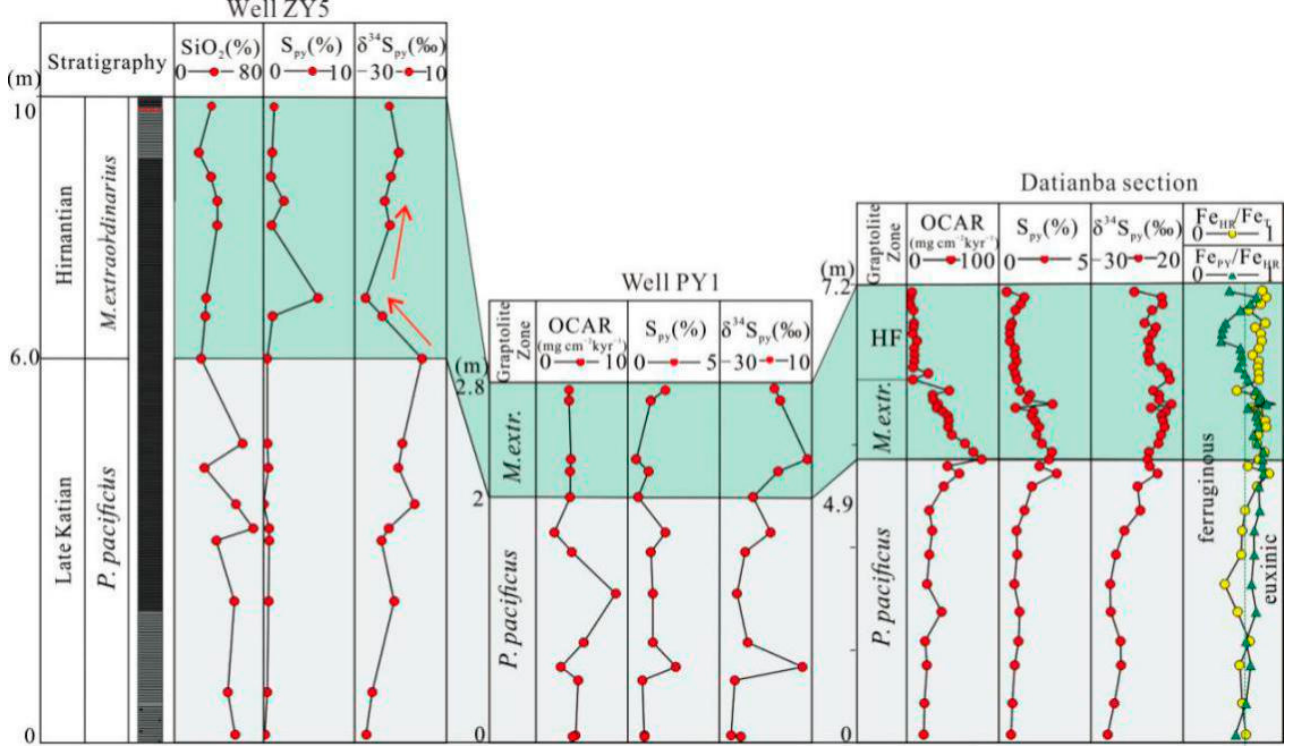
Figure 8. Comparison of productivity indicators, S py , δ 34 S py in the Katian-Hirnantian shales of Well ZY5 in the study area, Fe-speciation data and δ 34 S py data for the Datianba sections are from [8], OCAR (mass accumulation rates of organic carbon) values and δ 34 S py data for the Well PY1 are from [10]. M. extra. = M. extraordinarius , HF = Hirnantia Fauna.